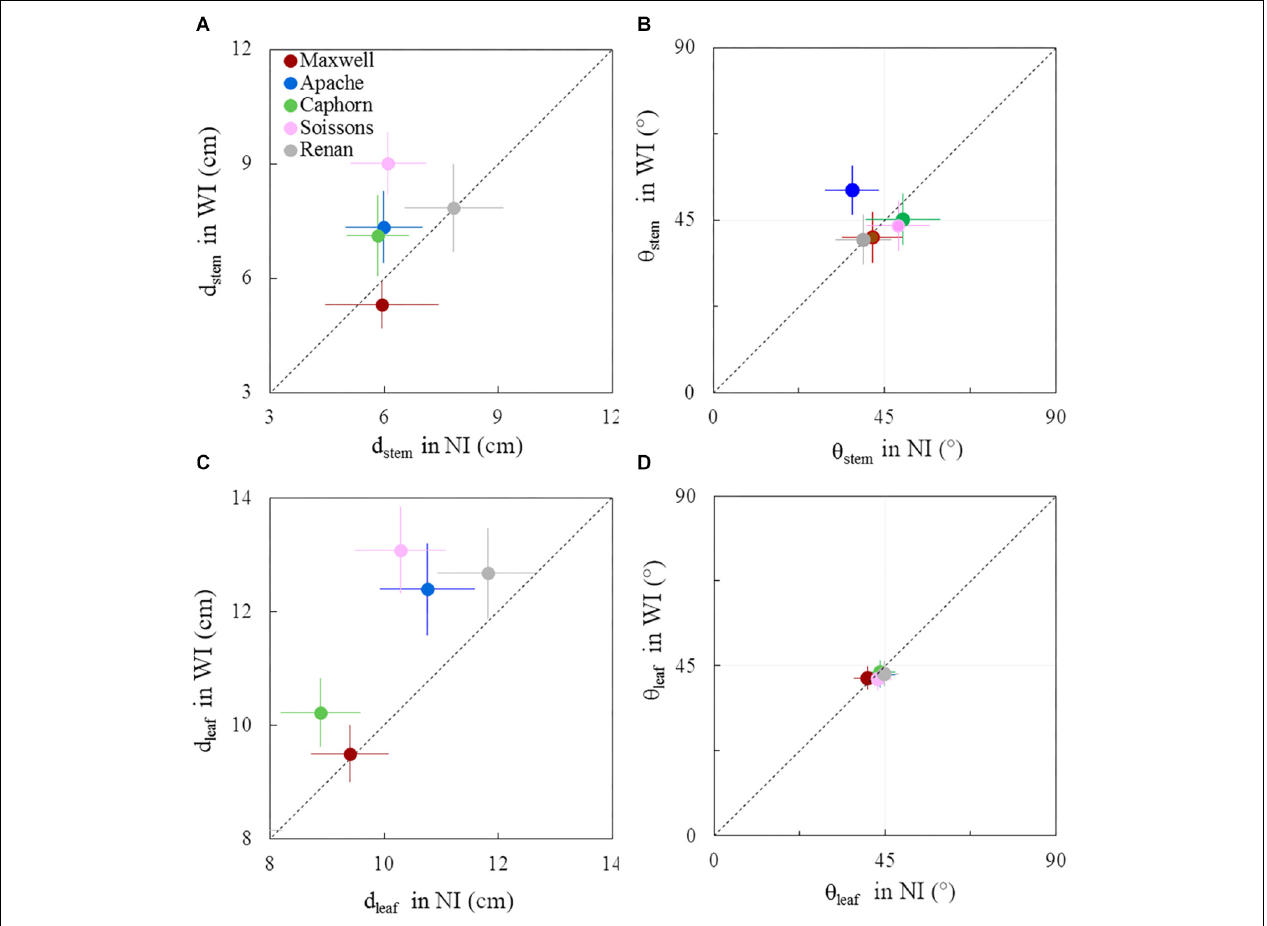
FIGURE 9 | Horizontal spacing and azimuth orientation of stems and leaves in WI treatments vs. NI treatments, at 1272 ◦ Cd. The stem spread ( d stem ; A ), leaf spread ( d leaf ; C ), stem azimuth angle ( θ stem ; B ), and leaf azimuth angle ( θ leaf ; D ). Symbols represent the mean values taking into account only well-developed axes, with h col ( 1 ) > 10 cm, for 30–60 plants per treatment. Error bars represent 95% confidence intervals of the mean estimates. The dotted line represents the line